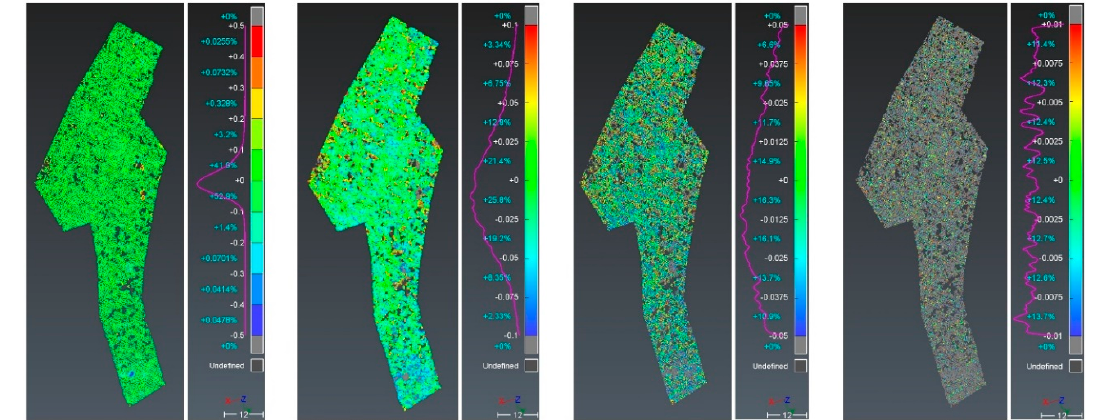
Figure 18. Comparison of UAS and ALS point clouds in the range up to 500 mm; up to 100 mm; up to 50 mm; and up to 10 mm. Table 6. SfM vs. ALS large areas—results.